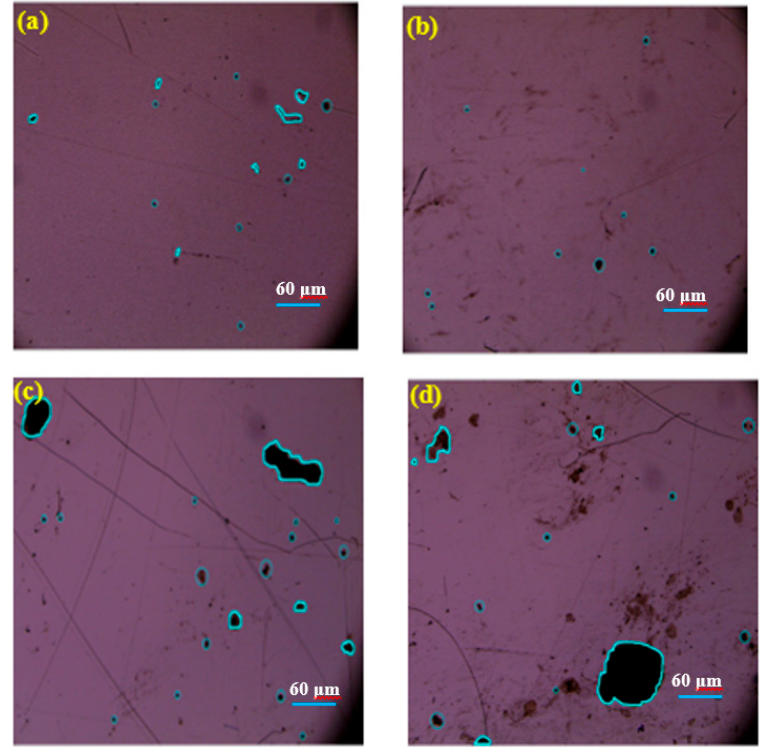
Figure 8. Optical images of CdTe films prepared at different sputtering distances. ( a ) 3.5 cm; ( b ) 4 cm; ( c ) 4.5 cm; and ( d ) 5 cm.